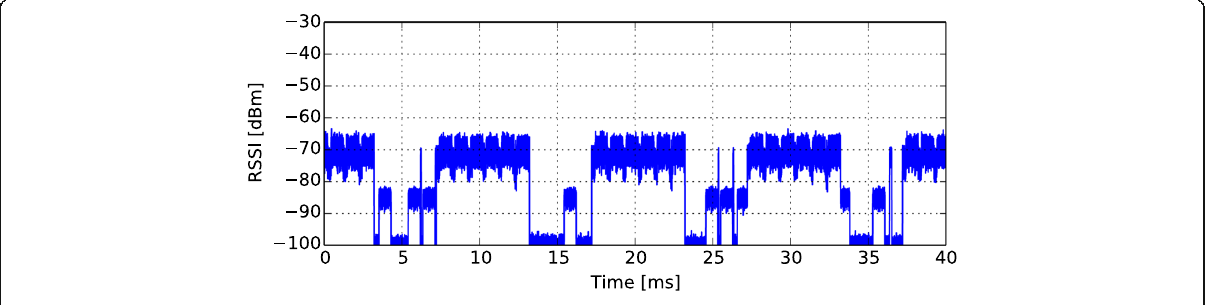
Fig. 11 WiFi DCF transmission over LTE-U pattern